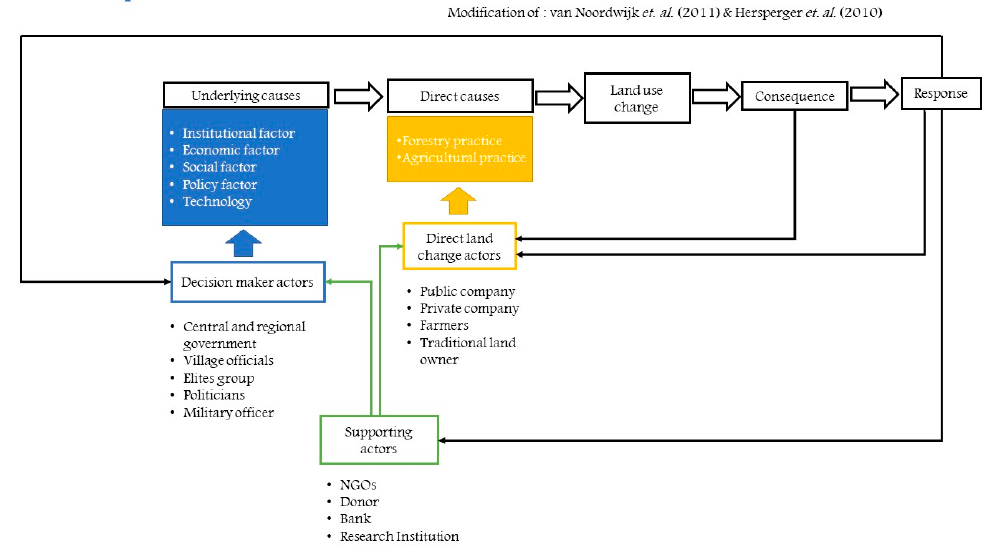
Figure 4. Conceptual framework for data extraction.